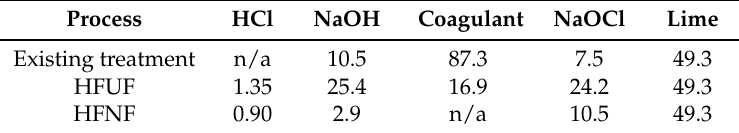
Table 3. GHG emissions from production of the chemicals (g CO 2 e/m 3 ).